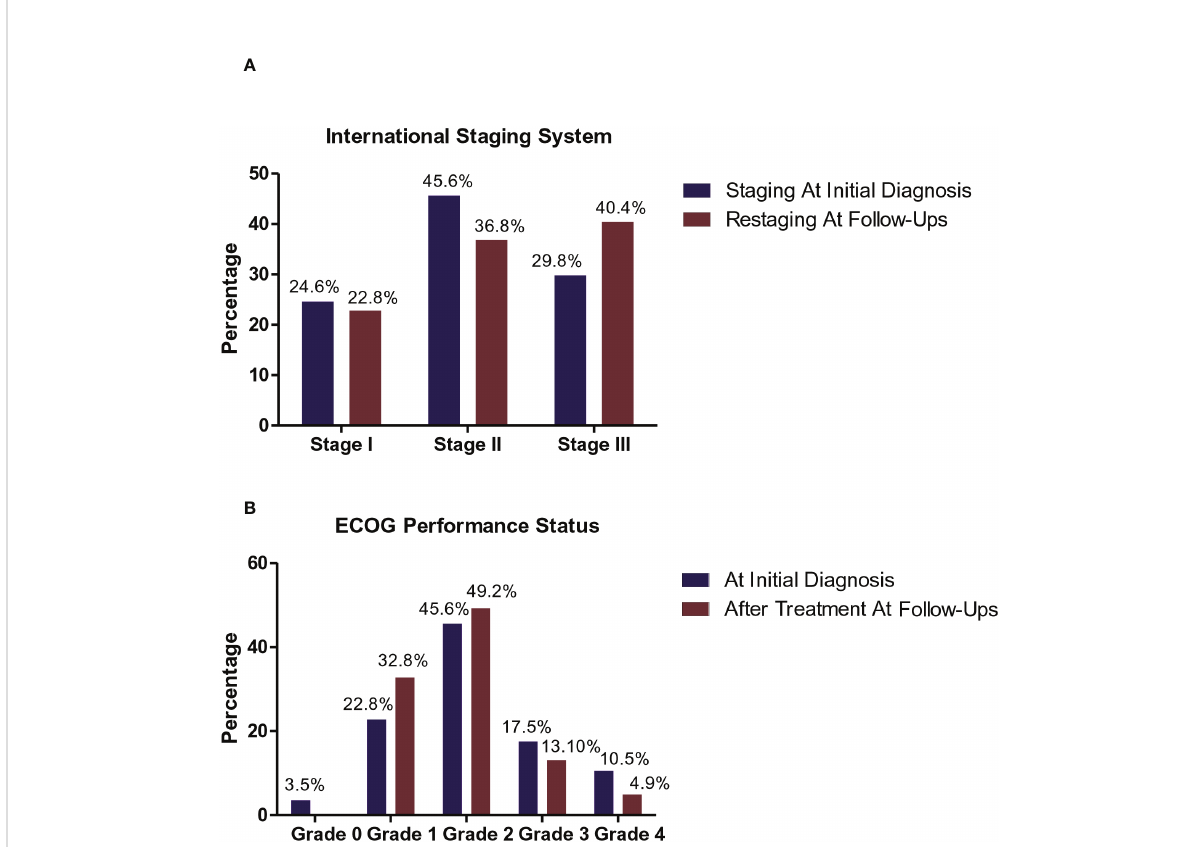
FIGURE 1 Staging and Eastern Cooperative Oncology Group (ECOG) performance status of the studied MM patients. International Staging System (ISS) Frequencies of MM patients at the initial diagnosis and following therapy (A) . At the initial diagnosis, 14/57 patients (24.6%) were classi fi ed as stage I, 26/57 (45.6%) with stage II, and 17/57 patients (29.8%) with stage III. While during follow-up after treatment, 13/57 patients (22.8%) were classi fi ed as stage I, 21/57 (36.8%) with ISS stage II, and 23/57 (40.4%) were of ISS stage III. ECOG performance status frequencies of MM patients at the initial diagnosis and during follow-up following therapy (B) . At the initial diagnosis, 2/57 (3.5%) of MM patients was recorded as grade 0, 13/57 (22.8%) of patients was recorded as grade 1, 26/57 (45.6%) of patients was recorded as grade 2, 10/57 (17.5%) of patients was recorded as grade 3, and 6/57 (10.5%) of patients was recorded as grade 4. While during their follow-up after treatment, 20/57 (32.8%) of MM patients was recorded as grade 1, 30/57 (49.2%) of patients was recorded as grade 2, 8/57 (13.10%) of patients recorded grade 3 performance status, and 3/57 (4.9%) of patients recorded grade 4.